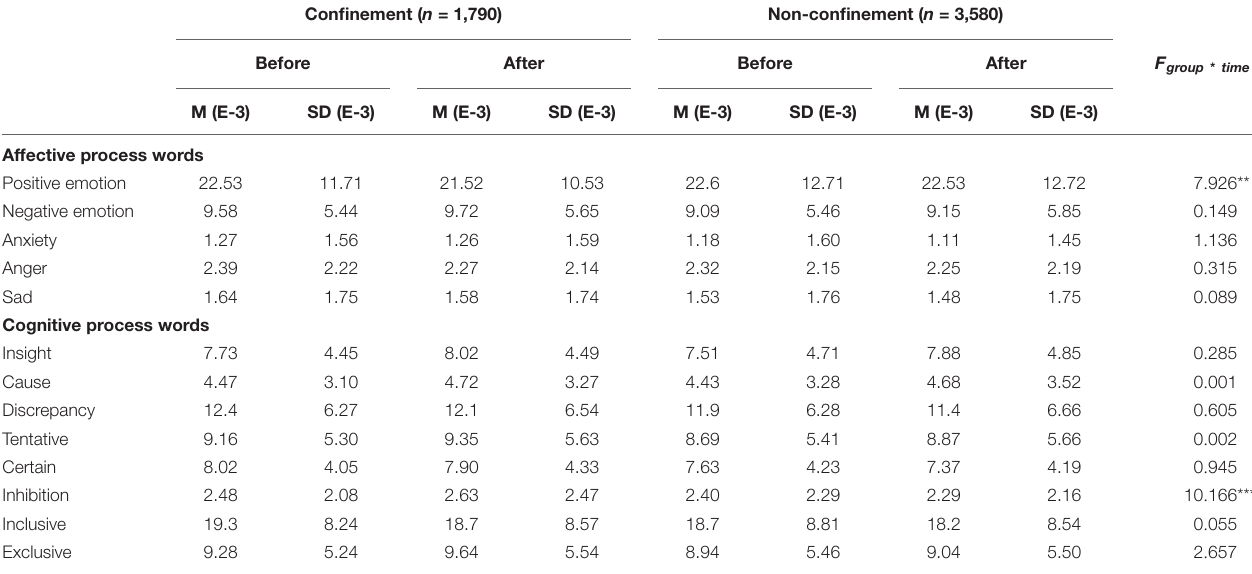
TABLE 4 | The results of RM ANOVA in all home confinement